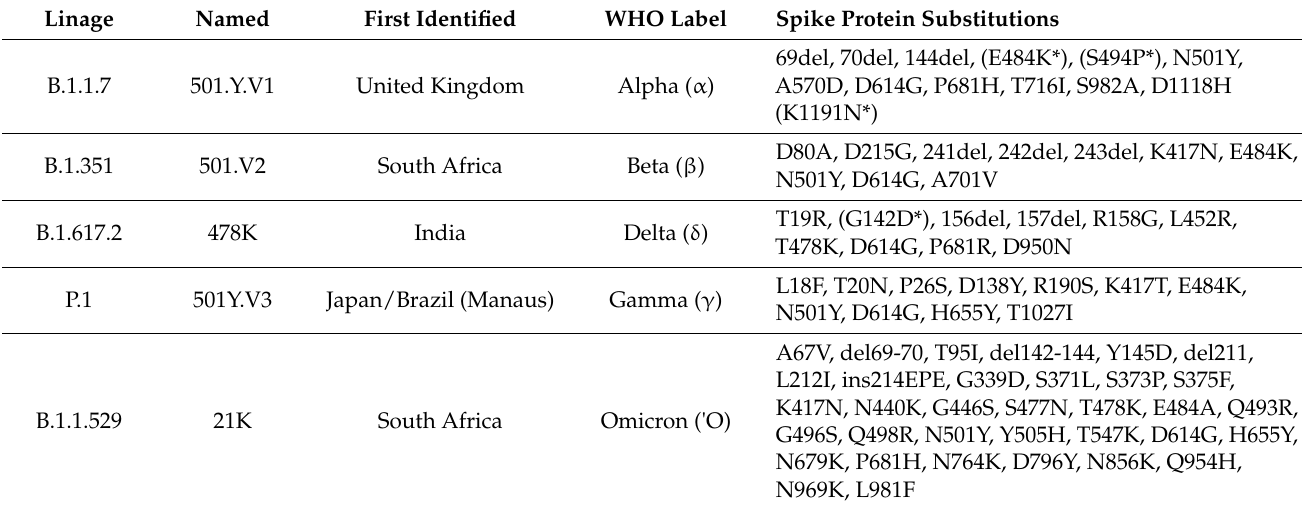
Table 2. Characteristics of SARS-CoV-2 Variants of Concern